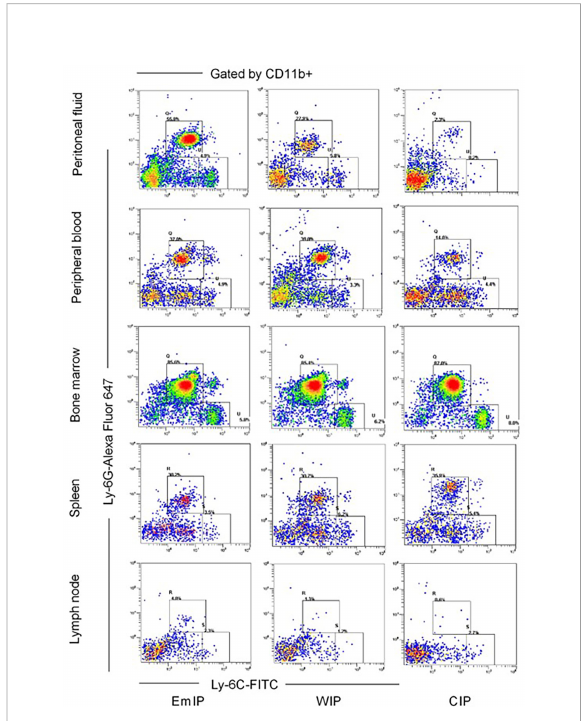
FIGURE 2 Gating strategy for identi fi cation of mouse MDSC subsets in peritoneal fl uid, peripheral blood, bone marrow, spleen, and lymph node of endometriosis mice from OVX+E2 model. After exclusion of doublets (not shown), live CD11b+ cells were gated, and the proportion of Ly6G and Ly6C cells was evaluated. G- MDSC (CD11b+ Ly6G+ Ly6Clo) and M-MDSC (CD11b+ Ly6G- Ly6Chi). EmIP, endometrium fragments and intraperitoneal; WIP, whole uterus tissue and intraperitoneal; CIP, sham control and intraperitoneal; G-MDSC, granulocytic myeloid-derived suppressor cells; M-MDSC, monocytic myeloid-derived suppressor